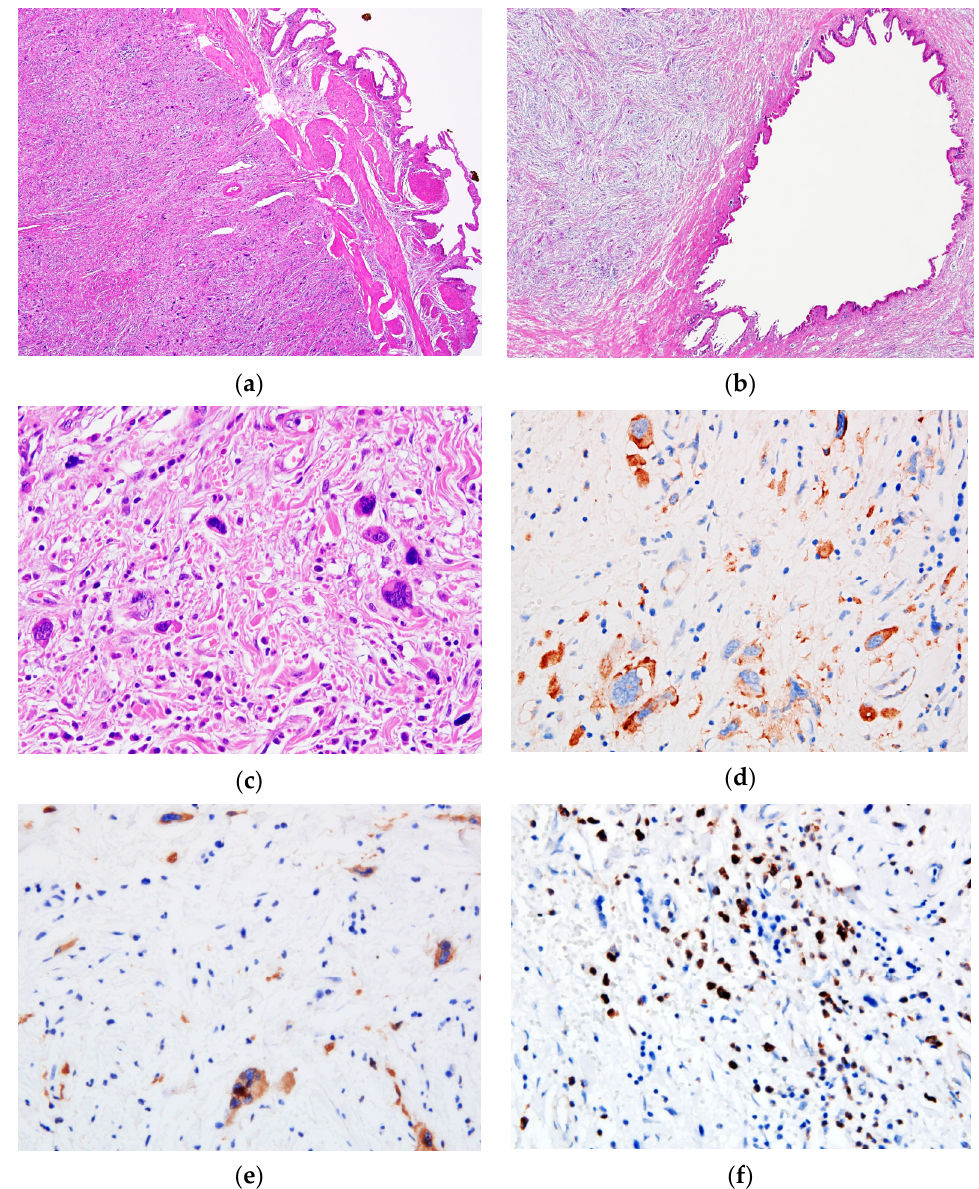
Figure 2. Microscopic features of the tumor. The ( a ) gallbladder and ( b ) cystic duct presented a thickened wall with fibro-myxoid stroma (Hematoxylin & Eosin (HE), ×4). ( c ) Through a high power view, the tumor is composed of isolated or small clusters of atypical megakaryocytes—hyperchromatic nuclei and abnormal chromatin clumping—as well as small cellular elements representing myeloid and erythroid precursors (HE, ×40). Atypical megakaryocytes stained positive for ( d ) CD31 and ( e ) CD61 antibodies, while granulocytic precursors showed a positive expression of ( f ) Myeloperoxidase (×40). The IHC profile of the atypical cells is also presented in Table 2. Myeloperoxidase (MPO) stained the granulocytic precursors. No CD34 positive blast cells were detected. Numerous small cells positive for CD15 were